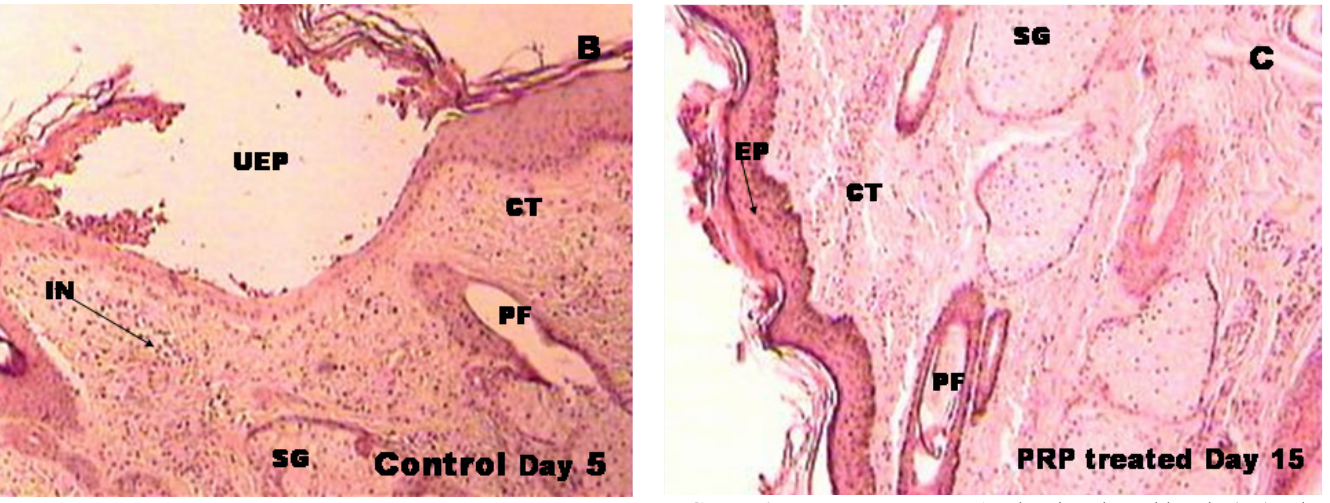
FIGURE 4 - PRP group at Day 15 showing the epidermis (EP). The dermis shows connective tissue (CT) with sebaceous glands (SG) and pilous follicles (PF) and focal areas of inflammatory process (IN).